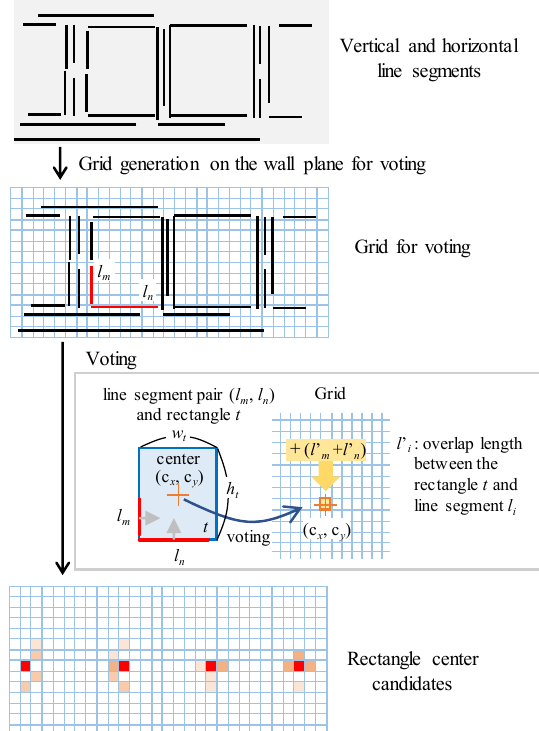
Figure 5. Voting for detecting rectangle from line